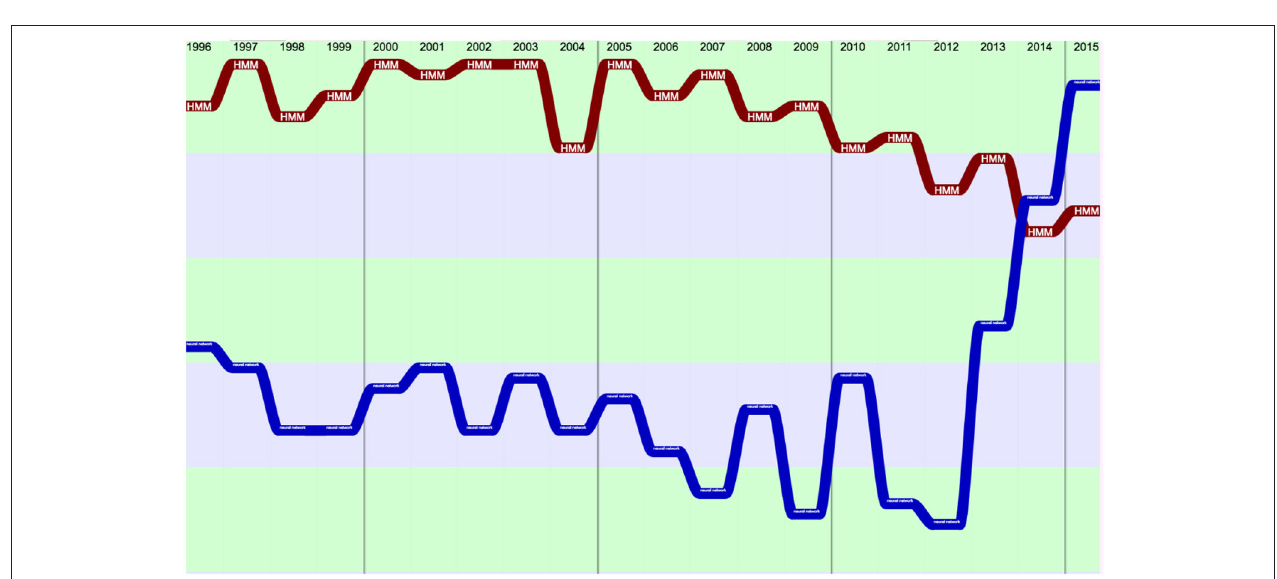
FIGURE 6 | Comparison of HMM and neural networks over 20 years (raw ranking, according to